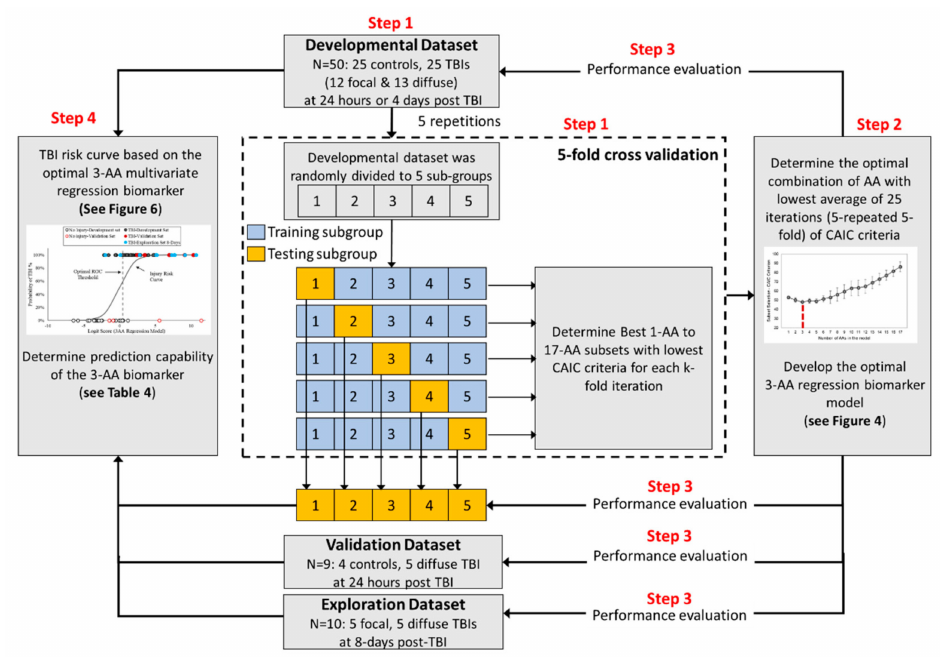
Figure 3. A schematic summarizing the workflow of the statistical process used in this study for development and evaluation of the optimal multivariate amino acid biomarker.